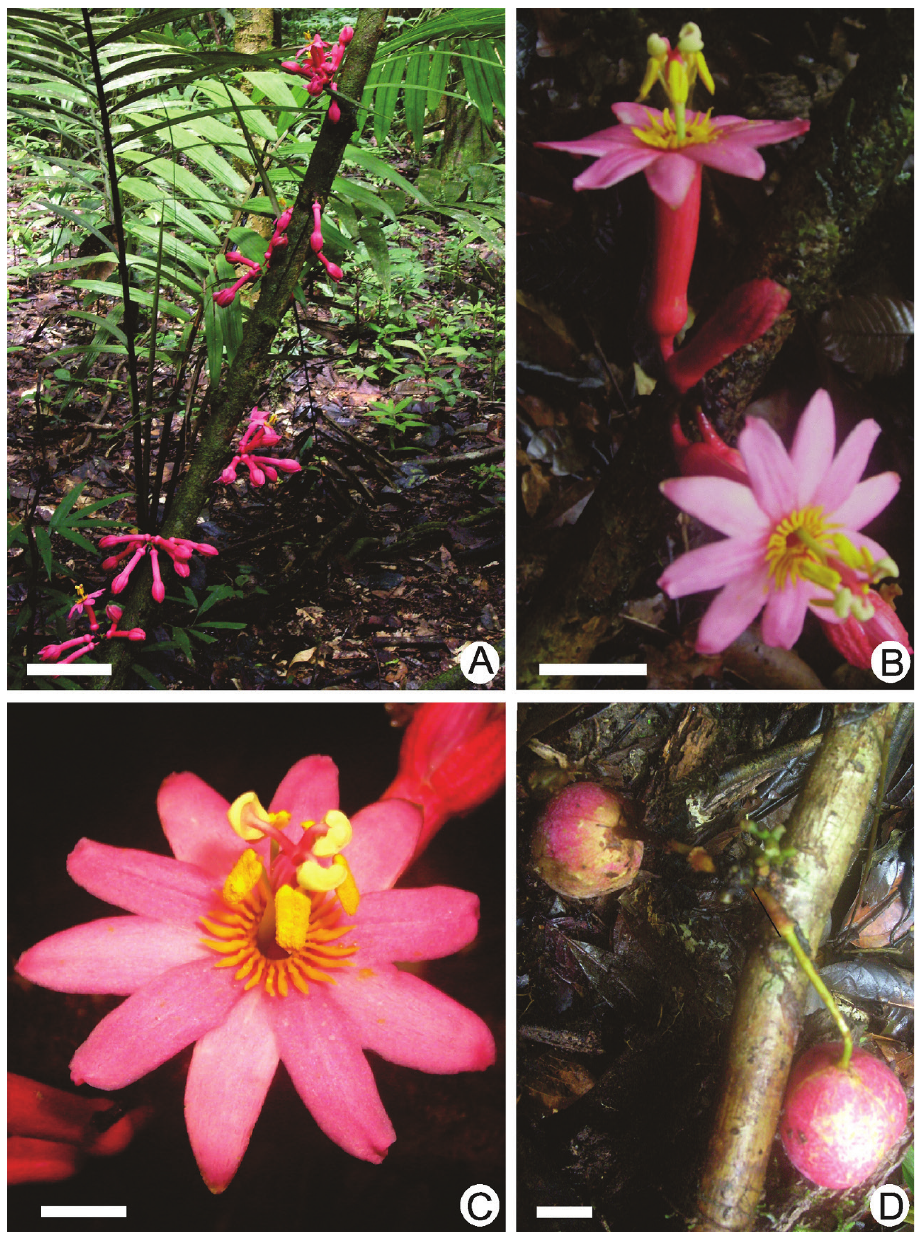
Figure 4. Passiflora amoena L.K. Escobar. A habit B inflorescence C flower D fruits. Scale bars: 10 mm ( A, C, D ); 2 mm ( B ). Photographs by S.C. Neto (S.V. Costa Neto et al. 2818,